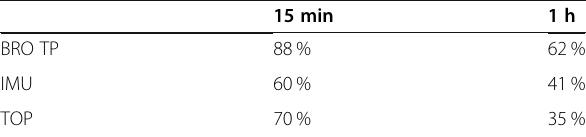
Table 2 Cell-free inactivation of SARS-CoV-2 titres. Titres of SARS-CoV-2 after incubation with selected herbal extracts for the indicated times. Values are expressed as percentage of the titre after treatment with PBS for 1 h (= 100 %) 15 min 1 h BRO TP 88 % 62 % IMU 60 % 41 % TOP 70 % 35